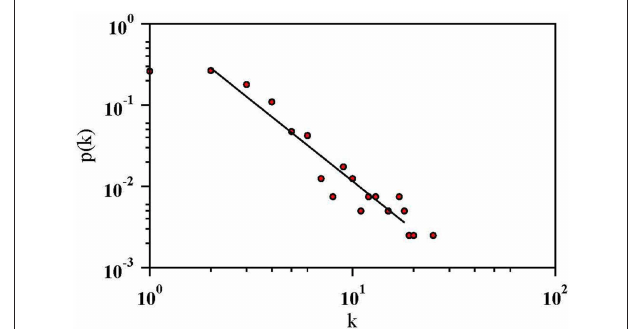
FIGURE 8 | Log–log plot of degree distribution when the radii of the disks are power law distributed with β = 1 . 0 for four values of number of disks N = 128 , 256 , 512 , and 1024 with N increasing from left to right. The initial slope, in all four cases, is compatible with a power law, p ( k ) ∼ k − α , where α ≃ 1 . 22 .